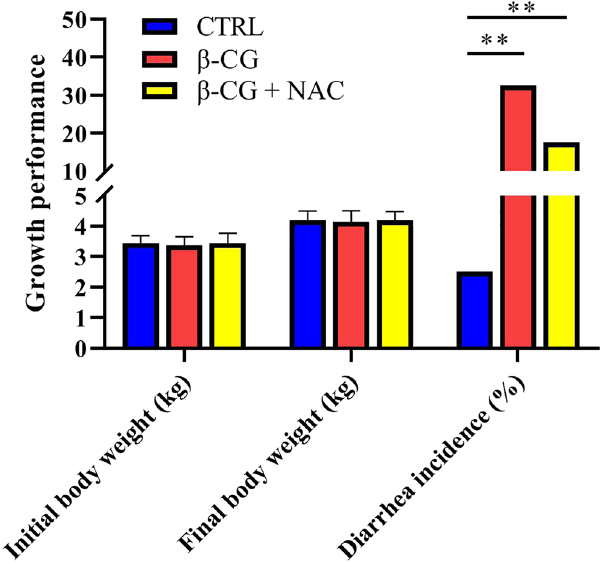
Figure 1. Growth performance and diarrhea incidence of piglets. Piglets in the control group were fed a liquid diet containing 10% casein, whereas those in the β-CG and β-CG + NAC groups were fed liquid diets containing 9.5% casein and 0.5% β-CG for 2 days. Thereafter, pigs in the β-CG + NAC group were orally administrated with 50 mg (kg BW) −1 NAC for 3 days, while those in the other two groups were orally administrated with the same volume of sterile saline. Body weights of piglets were recorded and the incidence of diarrhea was observed 3 times per day. Data are means ± SEM, n = 8. ** P < 0.01.